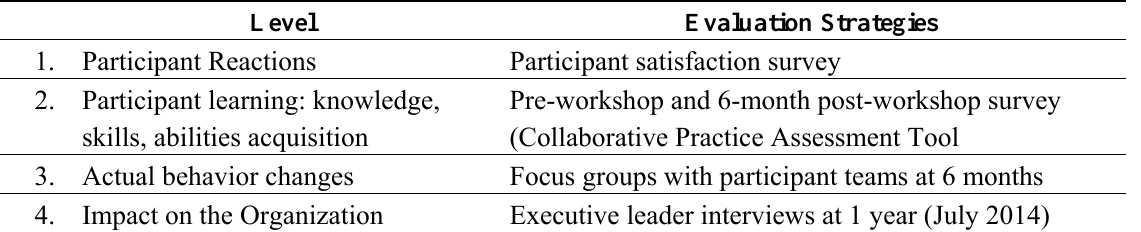
Table 3. Program evaluation strategies based on the four-level Kirkpatrick